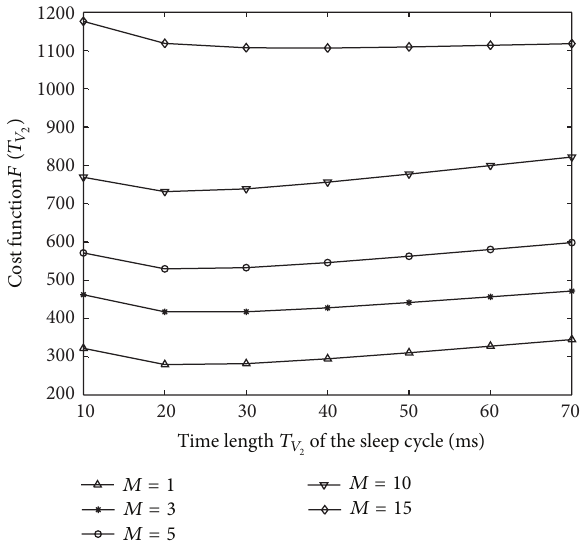
) versus sleep cycle 𝑇 2